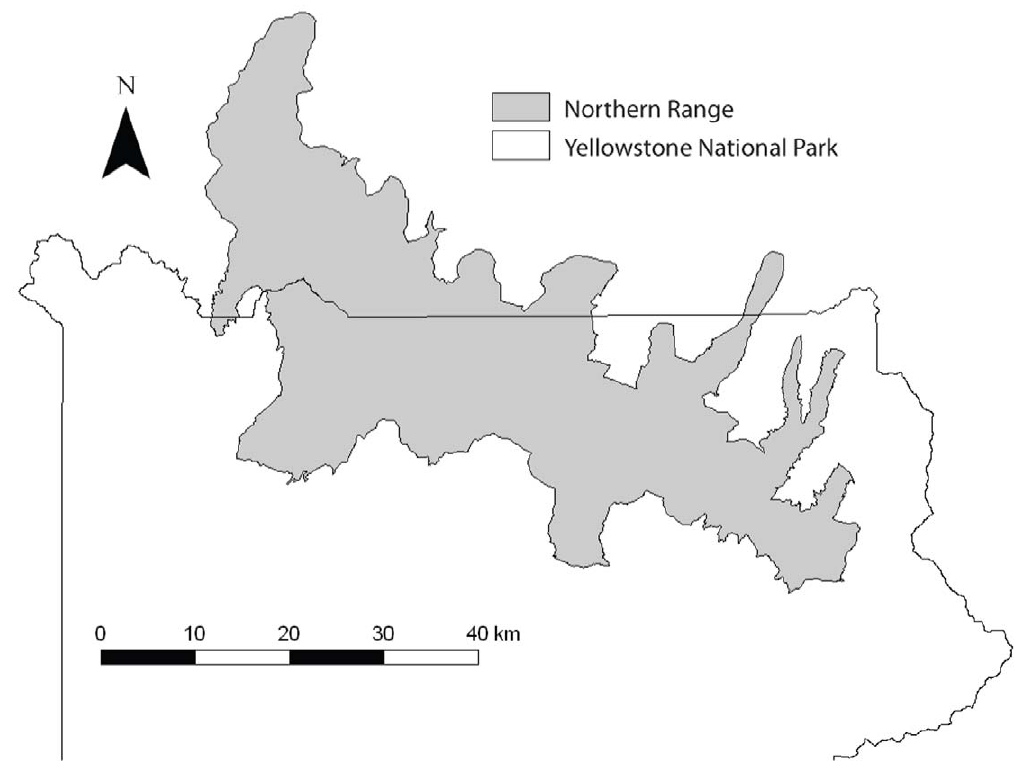
Figure 1. Map of the Northern Range. Northern Range wolves were monitored from 1997 to 2009.